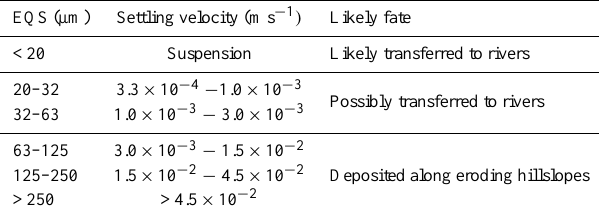
Table 2. Six settling velocities based on the Equivalent Quartz Size (EQS) classes, and the likely fate of eroded fractions based on the conceptual model developed by Starr et al.